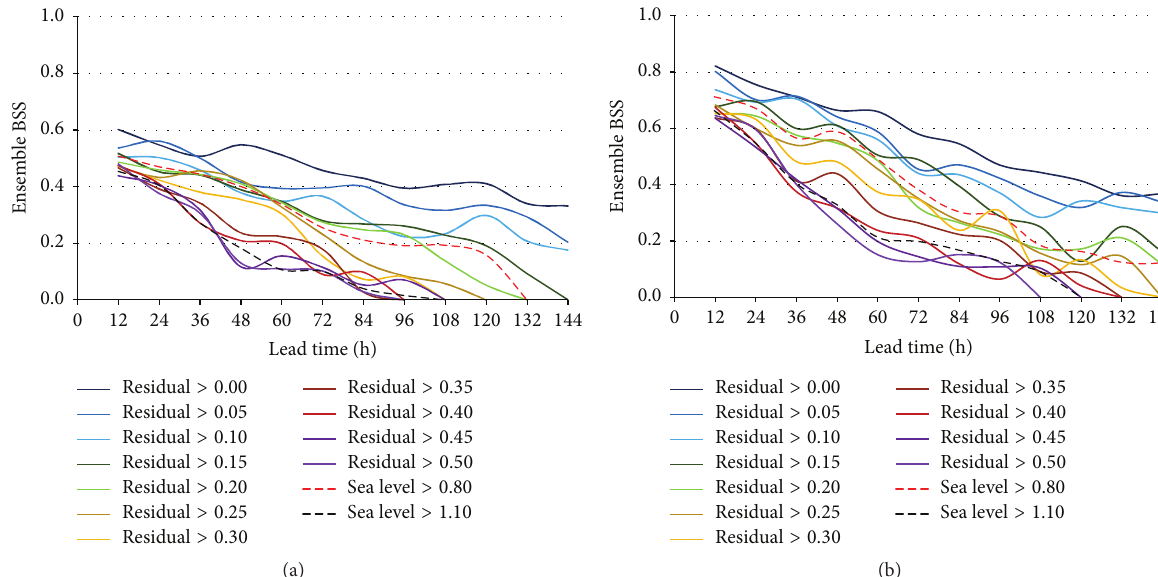
Figure 2: Brier skill score as function of lead time for the eleven SR thresholds (continuous lines) and the two SL thresholds (dash lines). In (a)/(b), the BSS is computed with respect to observations/hindcast.